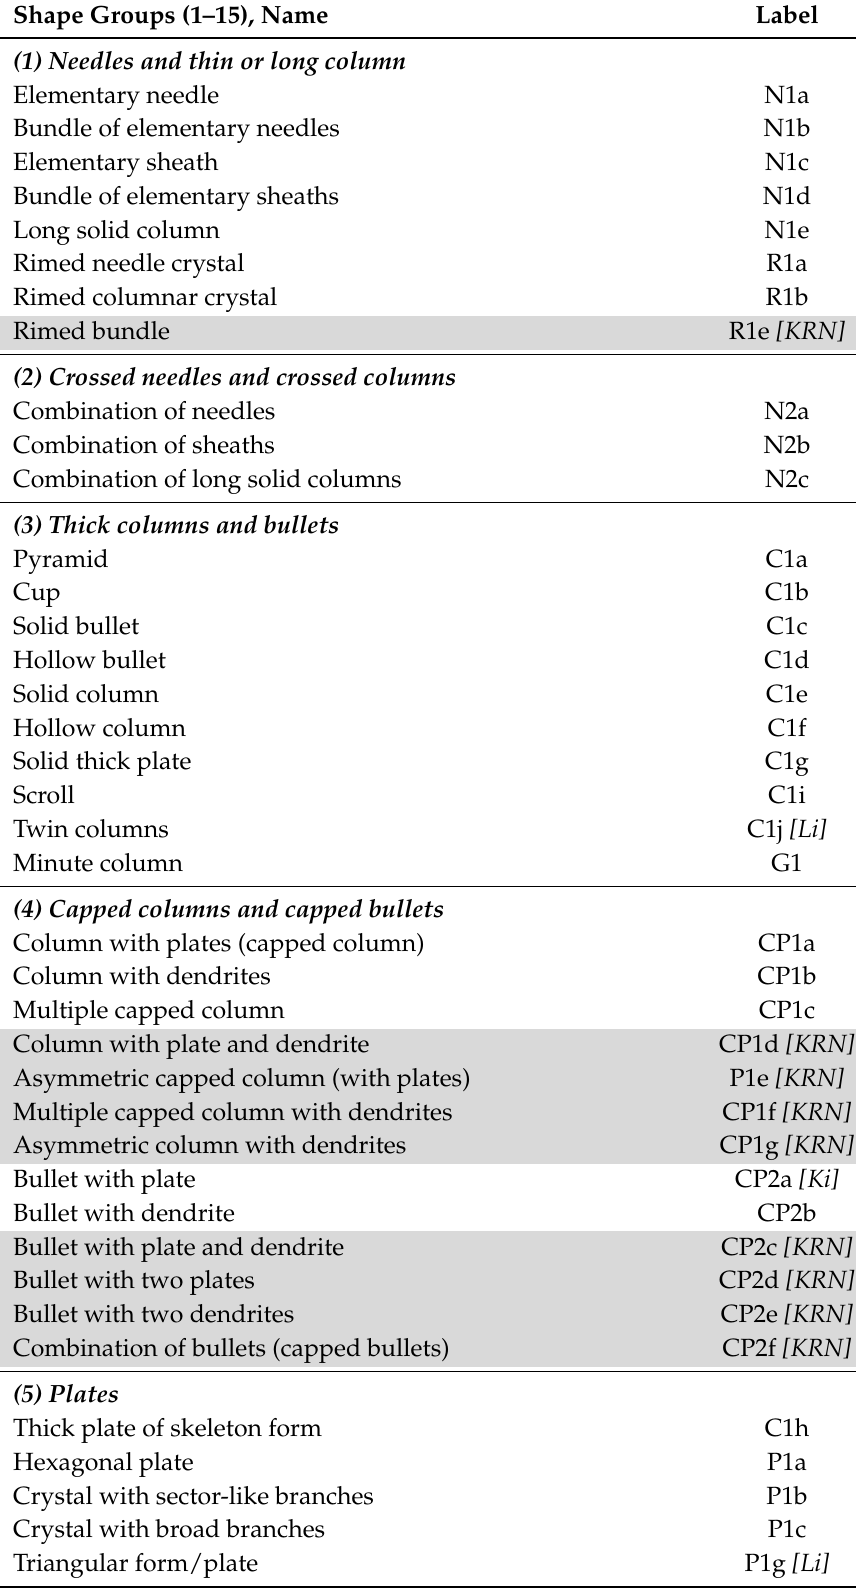
Table A2. Shapes of the updated classification sorted into shape